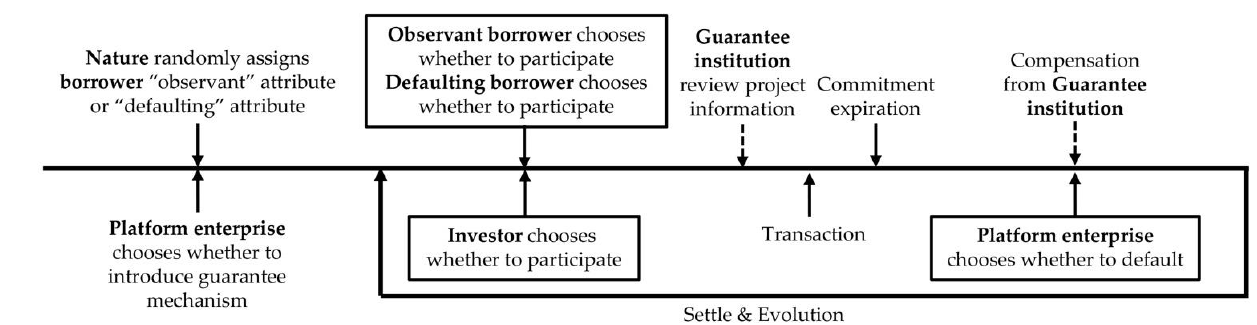
Figure 3. Strategy-making order of the evolutionary game of peer-to-peer lending platform.